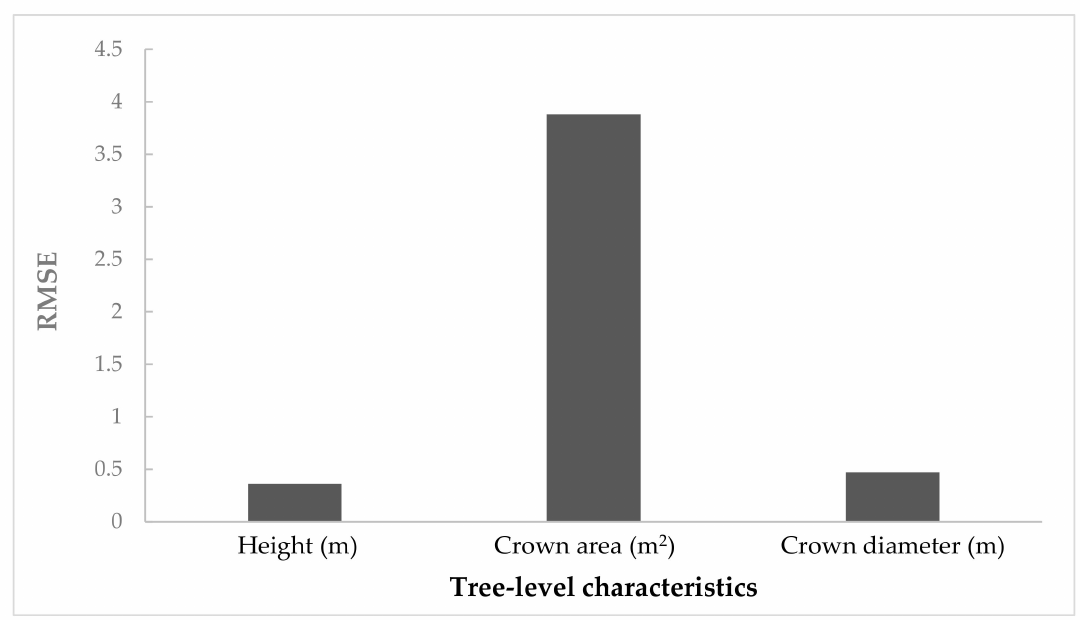
Figure 7. Absolute RMSE of simple regression models for tree-level characteristics with field data vs. those estimated with UAV.